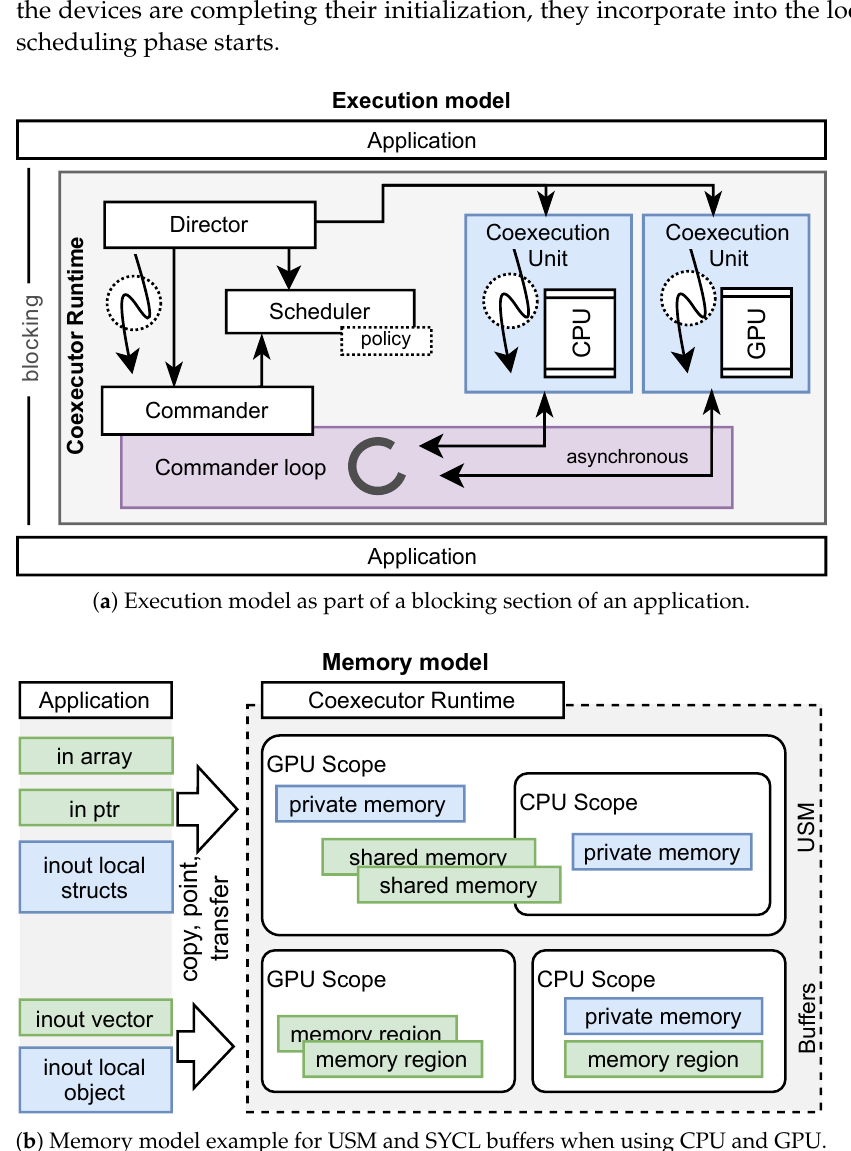
Figure 2. Coexecutor runtime considering an example of CPU-GPU dynamic